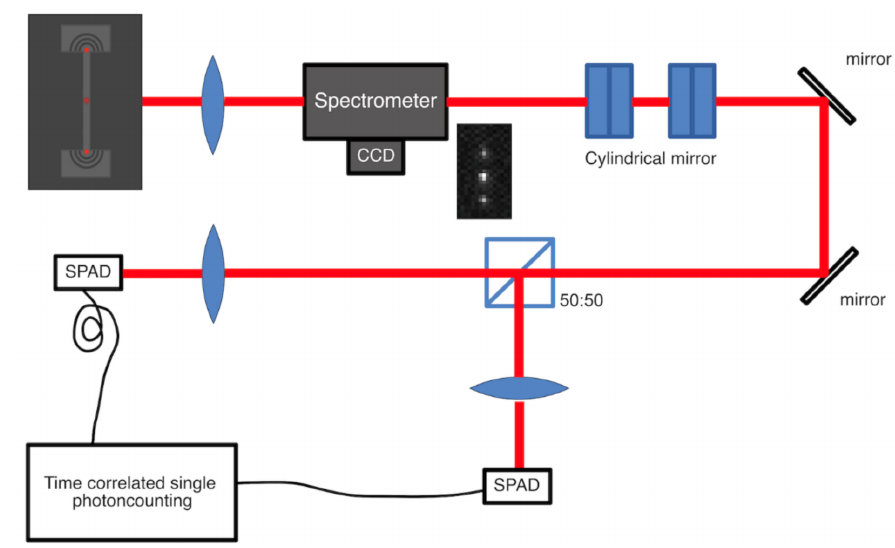
Figure 2. Schematic of the optical detection